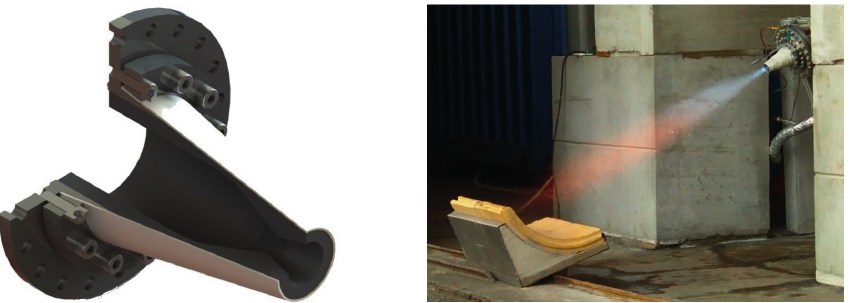
Figure 27. ( left ) sectional view of the OCMC combustion chamber with graphite lining and ( right ) its use in a hot